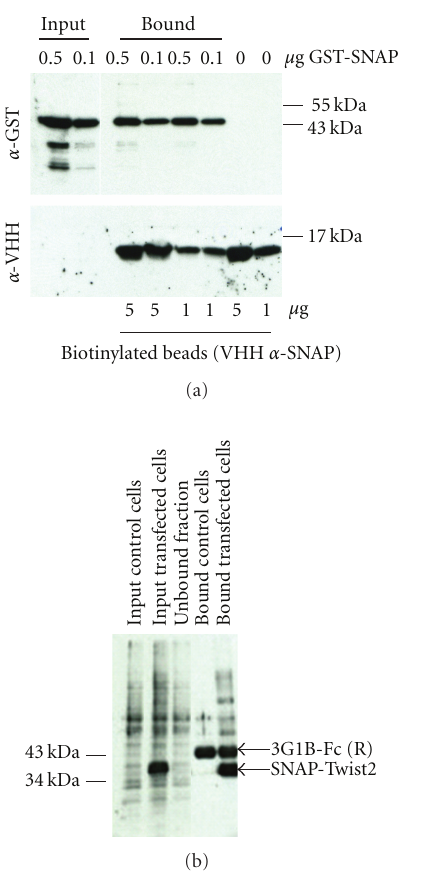
Figure 2: Application of anti-SNAP antibodies in immunopurifi- cation experiments. (a) Purified GST-SNAP (0.5 or 0.1 μ g) were incubated in the presence of the biotinylated anti-SNAP VHH 3G1B (5 or 1 μ g), and the antigen-antibody complex was precipitated using avidin beads. The proteins were separated by SDS-PAGE, blot- ted, and finally detected using either anti-GST (upper membrane strip) or anti-VHH specific antibodies (lower membrane strip). Biotinylated VHHs were incubated in the presence of avidin beads and in the absence of GST-SNAP as a control of the pull-down e ffi ciency. (b) Lysates from mammalian HEK293T cells transiently transfected with 20 μ g/plate plasmid for expressing the SNAP- Twist2 fusion construct were incubated with the anti-SNAP 3G1B- Fc(R) antibody, and the antigen-antibody complex was precipitated by means of Protein A.